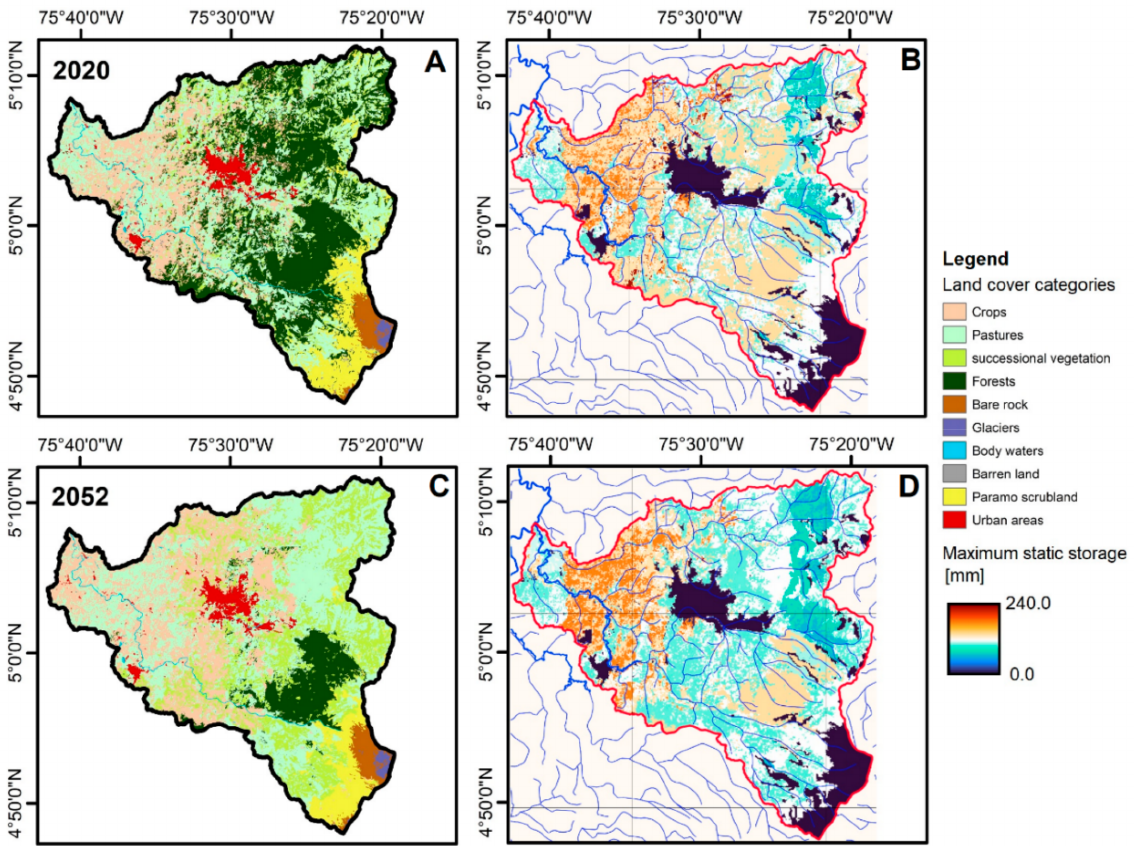
Figure 11. Schematical description of the land cover change in the Chinchin á River basin and its effect on a physical parameter of TETIS (maximum static storage). These results correspond to the trend scenario without implementing NbS conservation portfolios. Maps ( A , C ) present the land cover categories estimated for 2020 and 2052. Maps ( B , D ) show the respective estimated maximum static storage ( Hu ). Note that Hu decreases in many areas of the basin due to